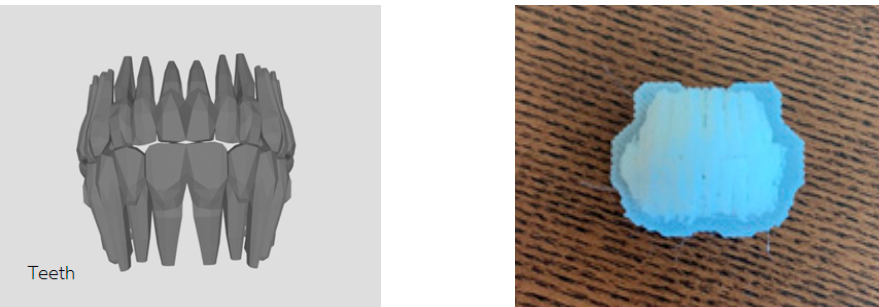
Figure 14. 3D rendering results and their 3D printing.